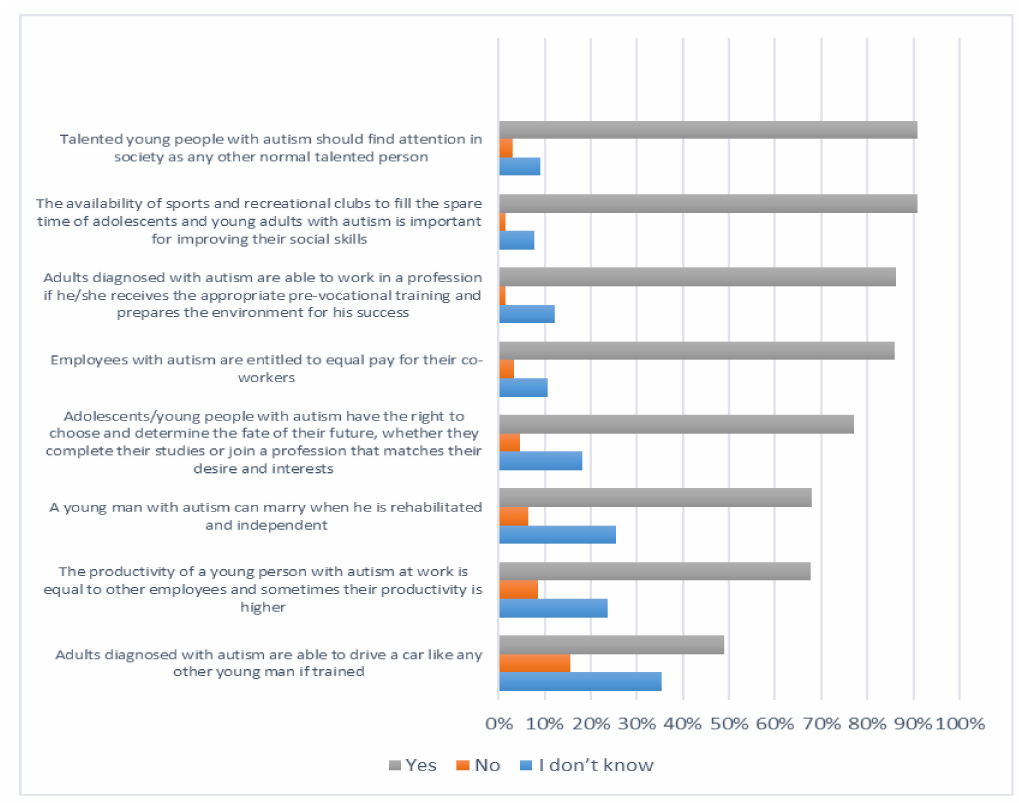
Figure 4. The level of knowledge of the abilities and needs of adolescents/young people with autism disorder.